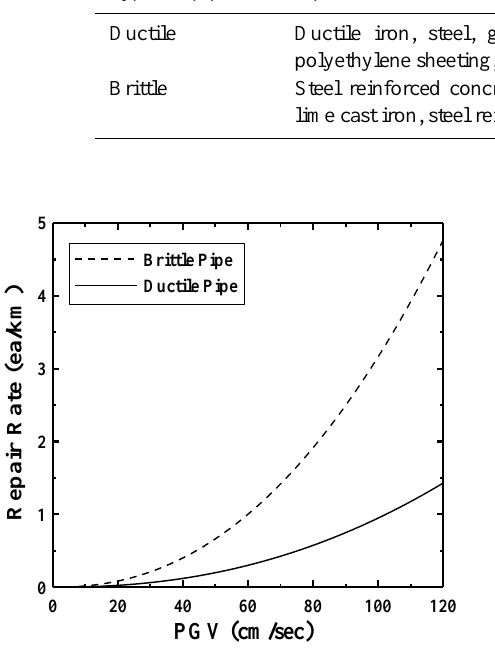
Table 1. Brittle and ductile pipelines classified by pipe materials (Ministry of Environment, 2010a, b). Types of pipeline